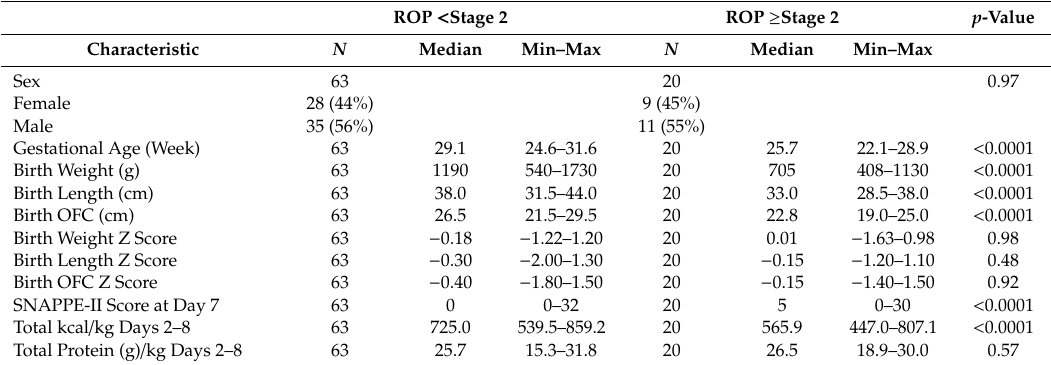
Table 2. Characteristics of Very Low Birth Weight (VLBW) infants with full data available, divided by ROP outcome.